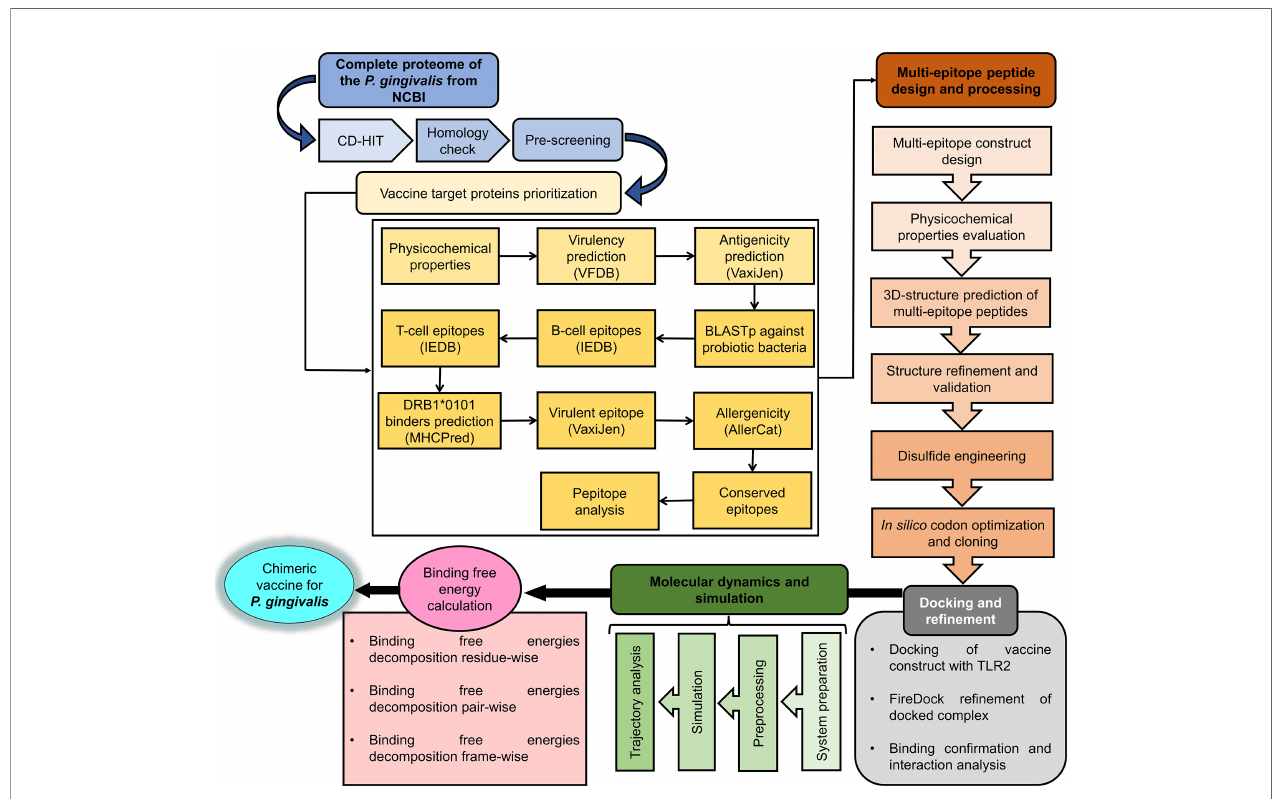
FIGURE 1 | Stepwise work fl ow designed for in silico vaccine design against P. gingivalis